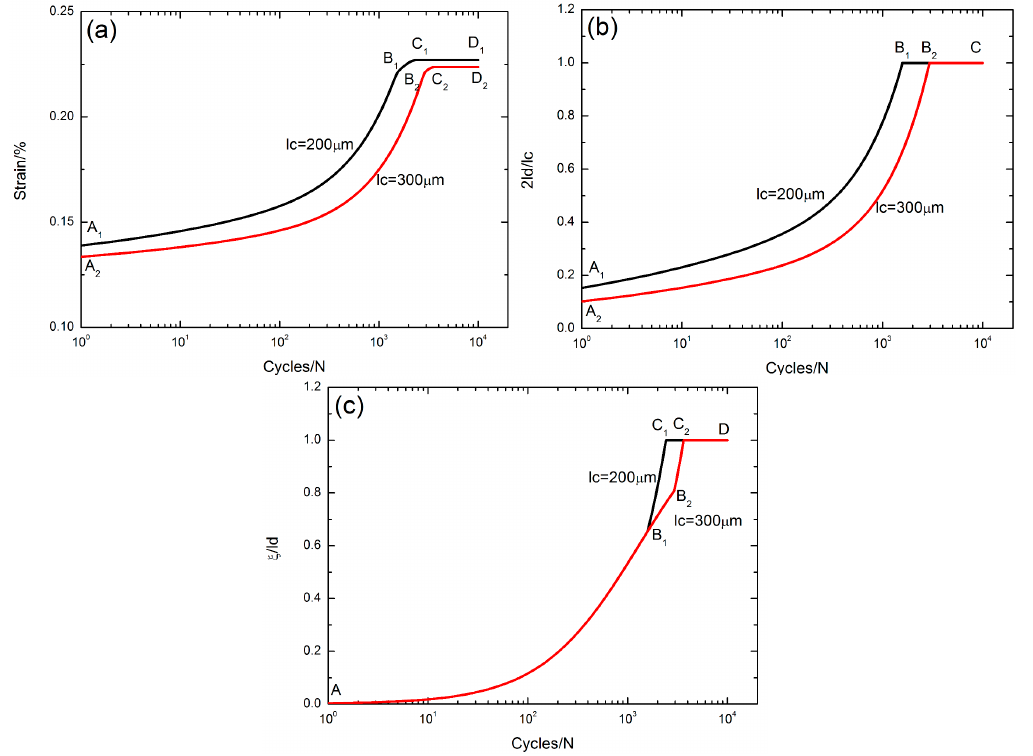
Figure 8. ( a ) The peak strain versus cycle number curves; ( b ) the interface debonded length 2 l d / l c versus cycle number curves; and ( c ) the interface oxidation length ξ / l d versus cycle number curves corresponding to different matrix crack spacings of l c = 200 and 300 μ m under σ max = 200 MPa with stress rupture time of t = 10 s at the oxidation temperature of Tem = 800 °C.